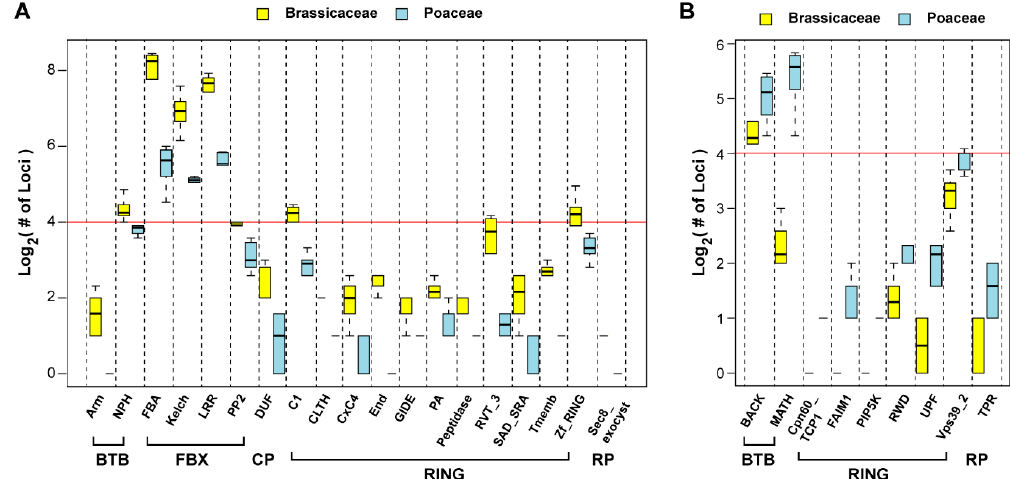
Figure 7. Domain enrichment assay revealed biased expansion of UPS subfamilies in Brassicaceae and Poaceae species analyzed. ( A ) Boxplots show 19 UPS subfamilies with a significantly more loci in Brassicaceae than in Poaceae. ( B ) Nine UPS subfamilies are shown to be enriched in Poaceae compared to Brassicaceae. Statistical significance was performed based on Student’s t-test ( p < 0.01). Not surprisingly, these varied UPS members are primarily from the three largest E3 ligase families, the FBX, RING, and BTB families. While there are two protein-protein interaction domains each from the BTB family that are preferentially enriched in Brassicaceae (Arm and NPH) and Poaceae (BACK and MATH) (Figure 7A,B), all four different types of overrepresented protein-protein interaction domains in the FBX family, FBA, Kelch, LRR, and PP2, are exclusively enriched in the Brassicaceae species (Student’s t-test, p < 0.01) (Figure 7A). There are a broad range of protein-protein